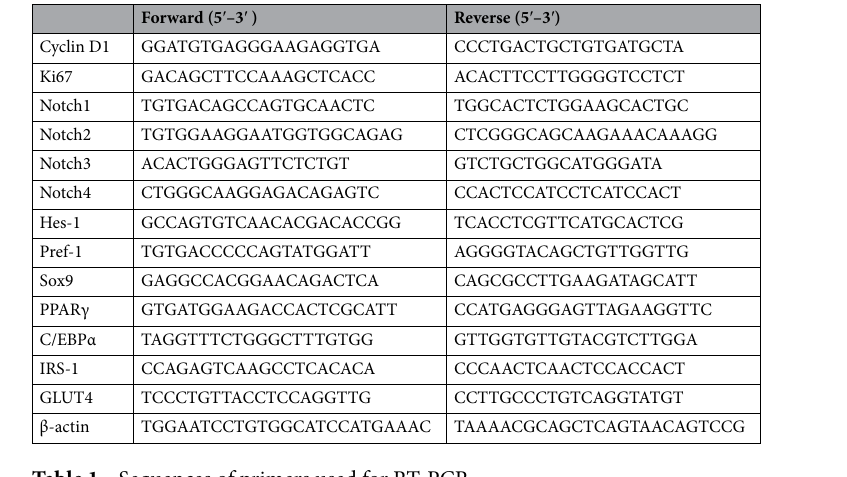
with TBS-T three times, protein expression was visualized using the enhanced Chemi-Lumi one system (Nacalai Tesque, Kyoto, Japan). The intensity of protein bands was normalized to the amount of β-actin (an internal con- trol, Cell Signaling Technology, MA; dilution, 1:2000) and expressed as ratio (fold increase) of the control value. Intraperitoneal glucose and insulin tolerance tests. At 16 weeks of age, the mice fed with HF/HS were subjected to intraperitoneal glucose tolerance test (GTT) and insulin tolerance test (ITT) using standard protocols, as described in detail previously 16 . Briefly, for GTT, the mouse was fasted overnight and then challenged with 2 g/ kg d-glucose (Sigma-Aldrich), followed by serial measurements of blood glucose up to 120 min using a blood glucose level monitor (Glutest Ace, Sanwa Kagaku Kenkyusho Co, Nagoya, Japan). For ITT, the mouse was fasted for 16 h before testing. Insulin (0.75 U/kg, Actrapid Penfill, NovoNordisk) was injected intraperitoneally, and blood glucose level was measured serially. In vitro experiments. Cell culture and reagents. All culture reagents were obtained from Sigma-Aldrich. Mouse ADSCs were prepared from 8-week-old N1+/− and WT mice, as described in detail previously 16 . 3T3-L1